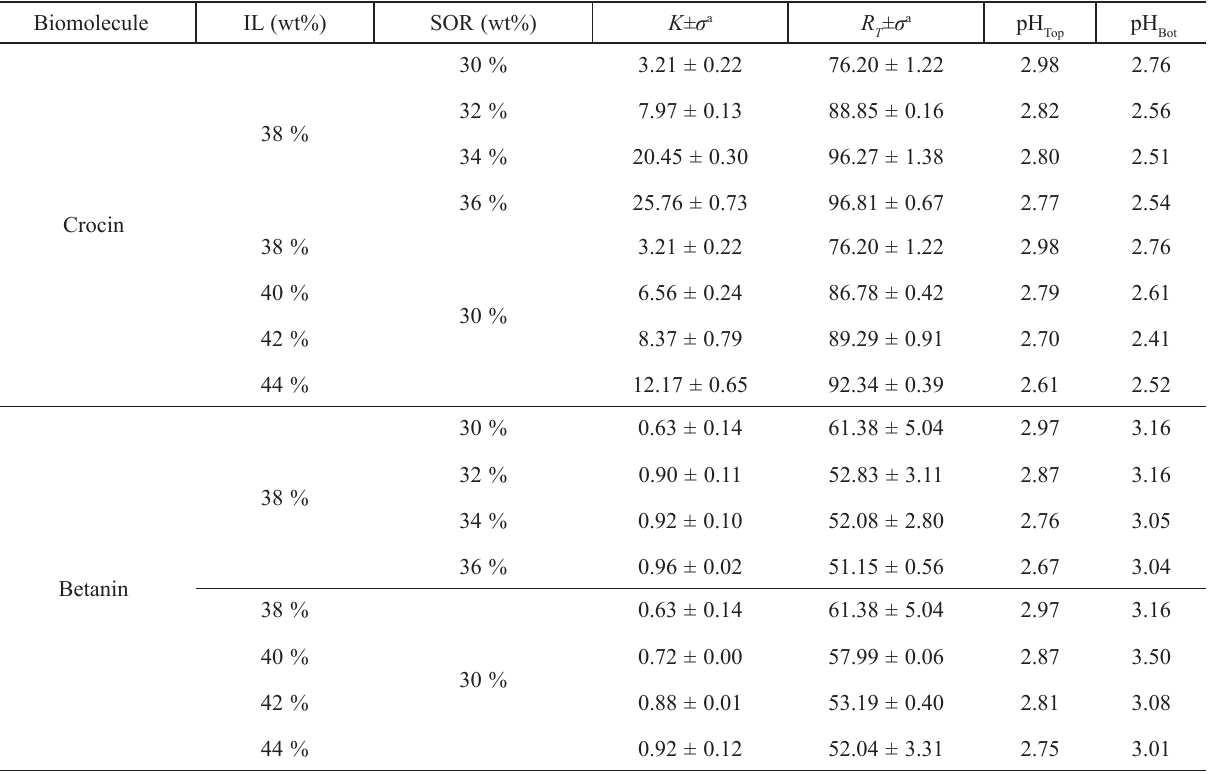
Table 3 – Weight percentage composition of each mixture point, partition coefficients, recovery percentages of crocin and betanin in the system of [P ] Br + Sorbitol + water at 298 K 4444